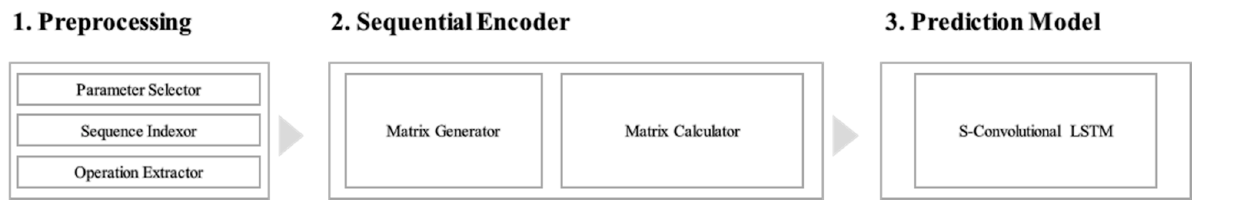
Figure 3. Process diagram of the maintenance cycle.